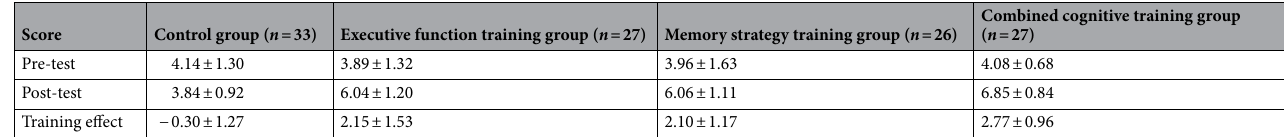
Table 4. Differences between the scores of the virtual week tasks before and after intervention (mean [ M ] ± standard deviation [ SD ]).